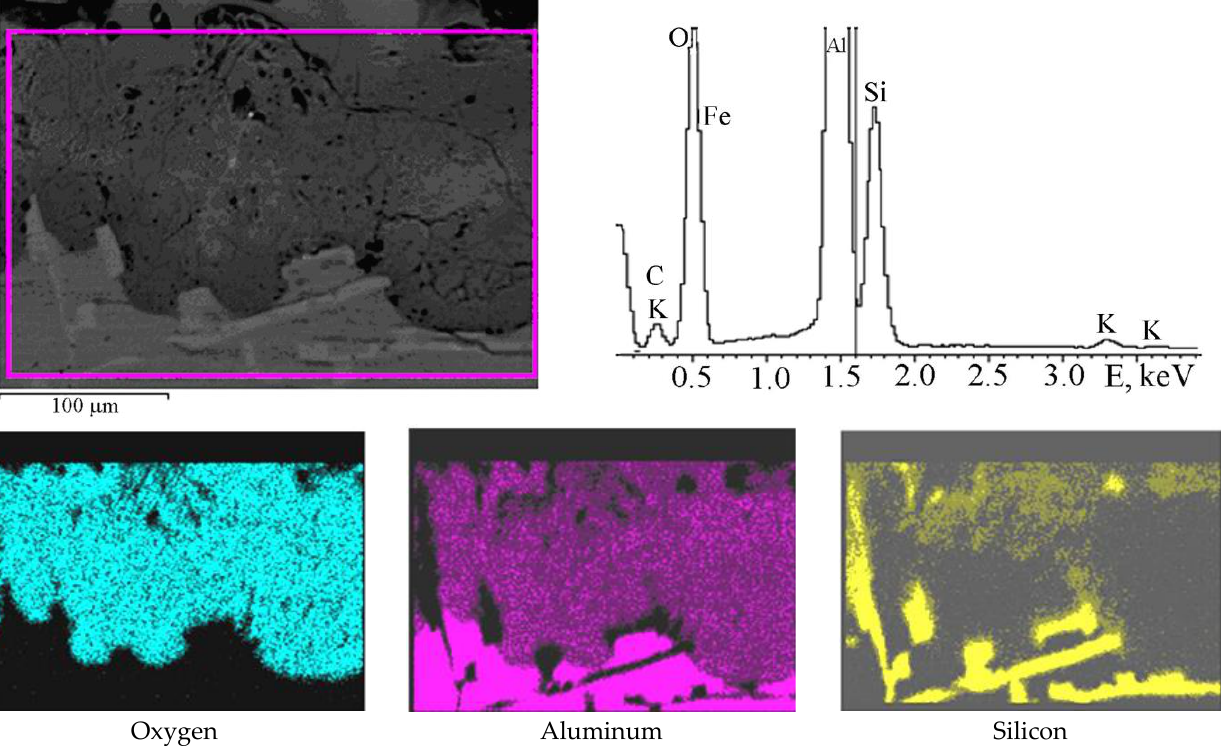
Figure 14. Distribution of oxygen, aluminum and silicon over the cross-sectional area of the PEO layer on the AK12 alloy synthesized in 3 g/L KOH + 2 g/L Na 2 SiO 3 electrolyte.